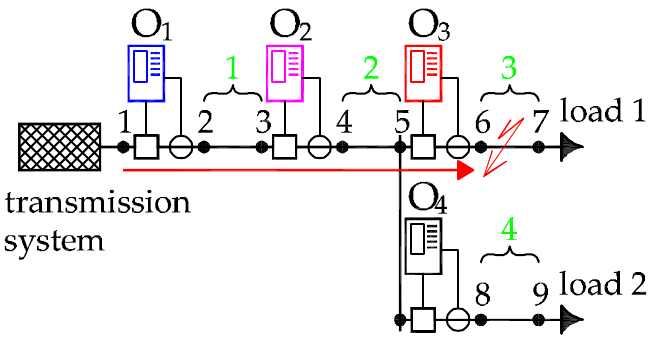
Figure 1. Radial system without distributed generation.